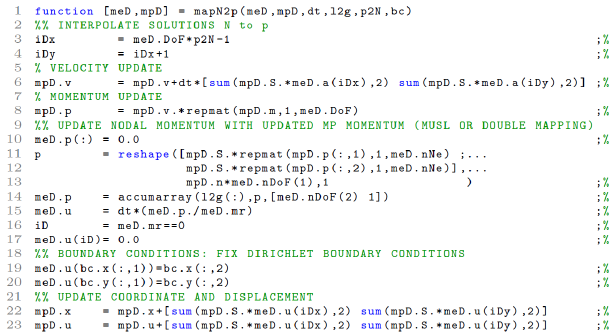
Figure 7. Code fragment 3 shows the vectorized solution for the interpolation of nodal solutions to material points with a double- mapping procedure (or MUSL) within the function mapN2p.m